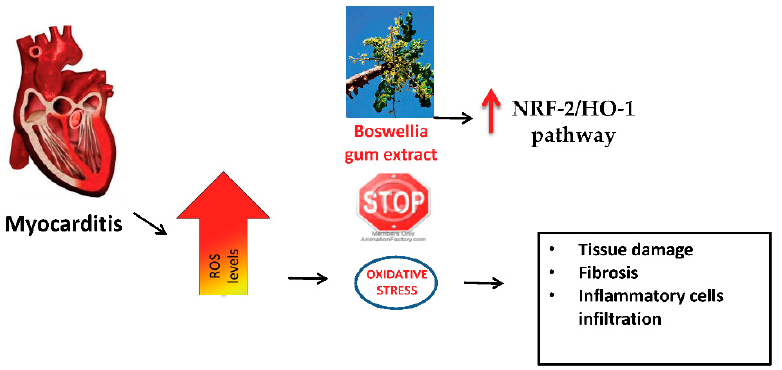
Figure 9. Summary of the effects of Boswellia gum extract during EAM.